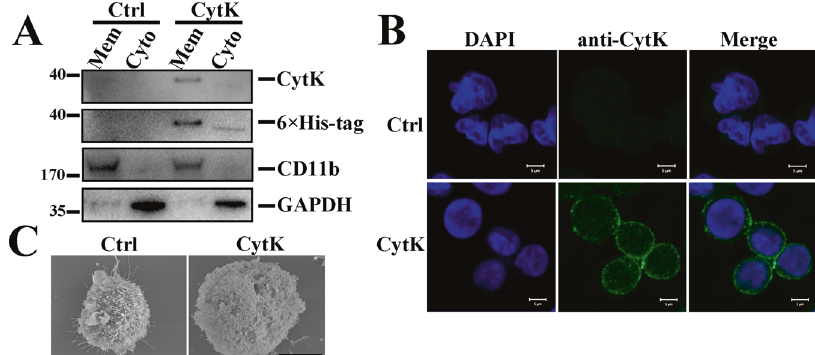
Fig. 5 CytK binds the cell membrane and causes membrane damage. A dTHP-1 cells were incubated with or without (control, Ctrl) His- tagged CytK for 25 min. The membrane fraction (Mem) and a cytosolic fraction (Cyto) of the cells were immunoblotted with antibodies against CytK, His-tag, CD11b, and GAPDH. CD11b, cell membrane marker; GAPDH, cytosolic protein marker. B dTHP-1 cells were incubated with or without (Ctrl) CytK as above and stained with DAPI. The localization of CytK was examined by immuno fl uorescence microscopy using an anti- CytK antibody. Scale bar, 5 μ m. C dTHP-1 cells were incubated with or without (Ctrl) CytK for 1 h, and the cells were subjected to scanning electron microscopy. Scale bar, 10 μ